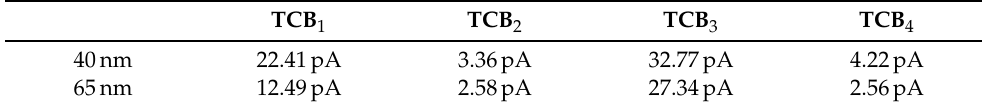
Figure 7. Tiny consuming blocks. Table 2. Minimum currents consumed by the tiny consuming